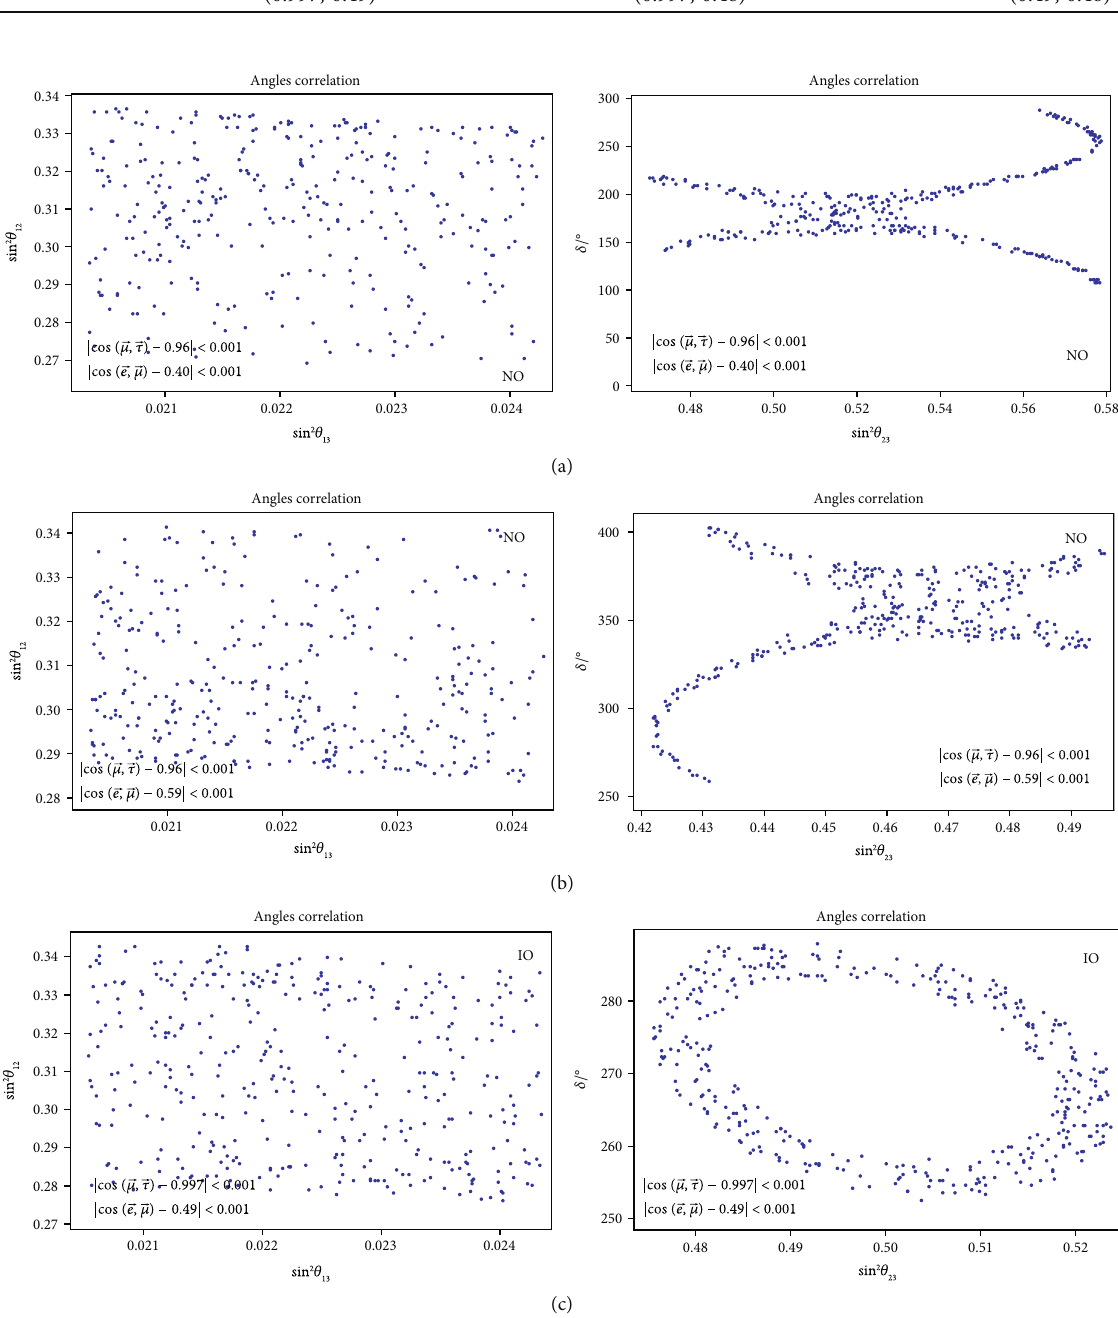
Figure 7: Leptonic mixing parameters constrained by the correlations between two included angles of ( cos ð μ (a) NO case with the constraints of j cos ð μ − 0 : 96 j < 0 : 001 and j cos ð e ! , μ ! Þ − 0 : 59 j < 0 : 001 . (c) IO case with the constraints of j cos ð μ ! , τ ! Þ − 0 : 997 j < 0 : 001 and j cos ð e ! , μ ! Þ − 0 : 49 j < 0 : 001